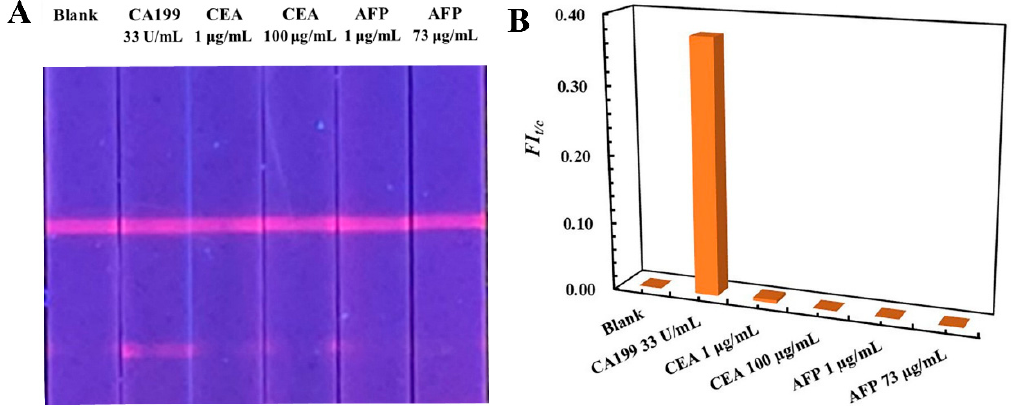
Figure 3. Visible result ( A ) and FI t/c ( B ) value of the TRFM-based LFIA for specificity evaluation.